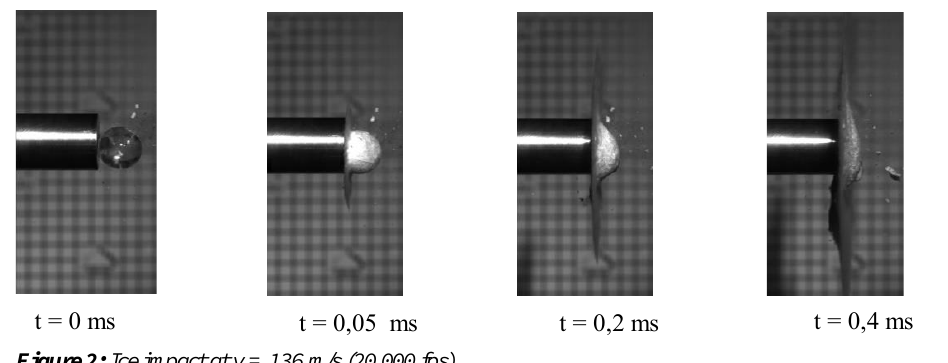
Figure 2: Ice impact at v = 136 m/s (20 000 fps) Table 1 . Spread area measured with a tracking software for an ice impact at 136 m/s and an artificial bird impact at 135